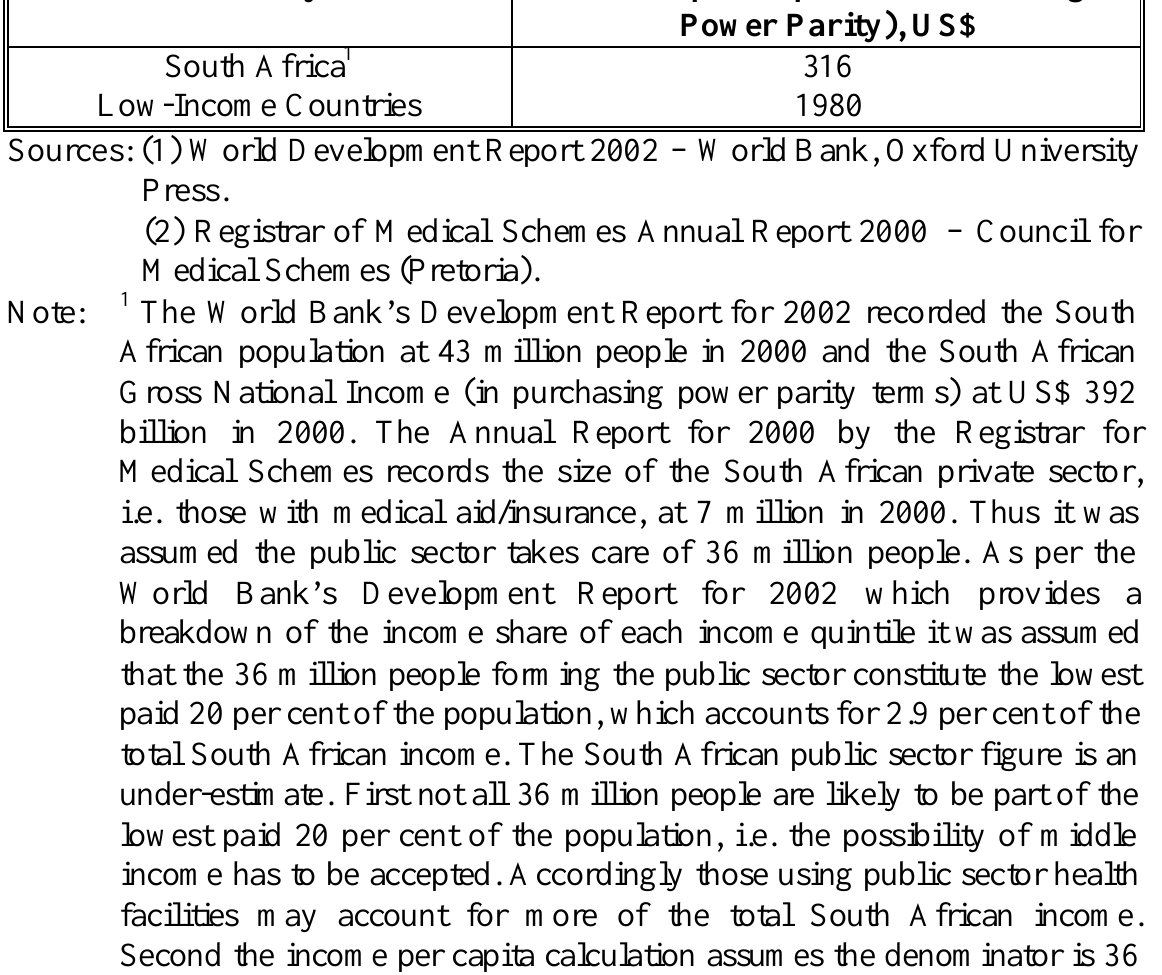
Estimated Income Per Capita For The Public Sector, 2000 Country Income per Capita (in Purchasing South Africa 1 Low-Income Countries